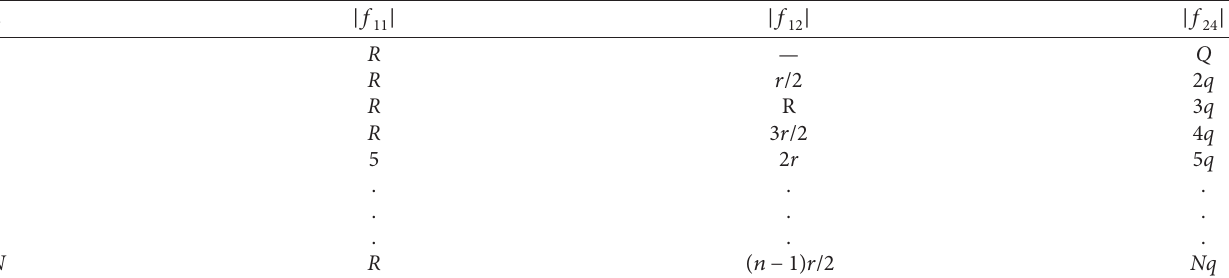
C ( R ) . (b) 2D lattice of TUC 4 8 , f , and f with given number of 11 12 24